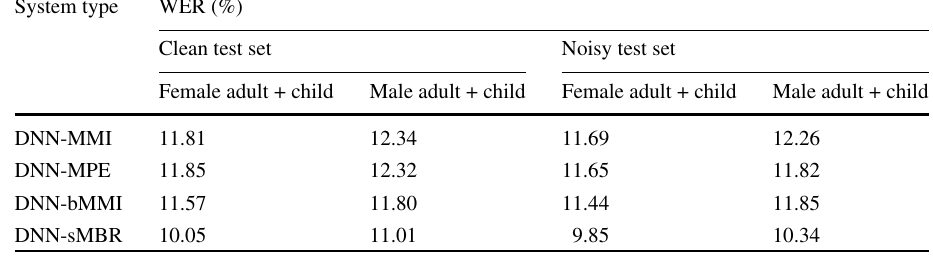
Table 10 An overview of WER obtained from perturbation training using PNCC and VTLN approaches in matched and mismatched systems using clean and noisy test sets